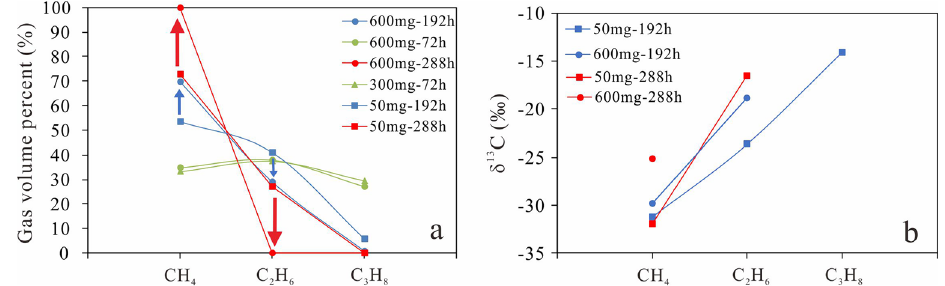
Figure 7. Variation of the volume percentages ( a ) and δ 13 C ( b ) of alkane gases with magnesium sulfate